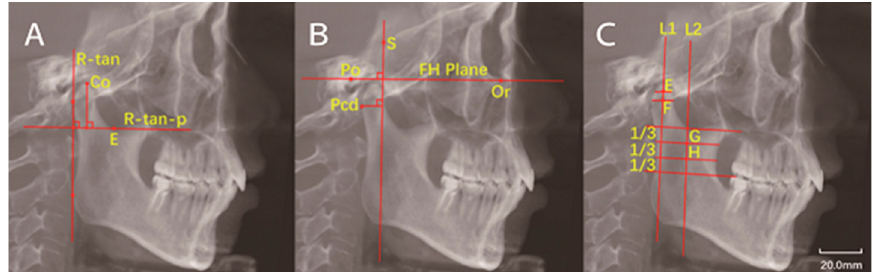
Figure 4. Measurements in the sagittal view of the condyle. ( A ): Condylar height—the distance from Co to the line perpendicular to the R-tan line and passing the deepest point of the sigmoid notch (R-tan- p ). ( B ): Pcd-FH- p (S)—the distance from Pcd to the line perpendicular to FH plane and passing S point. ( C ): Condylar neck angle—the center of the widest width of the condyle (F point) and the center of the middle part between the top and the widest width of the condyle were marked (E point); a line was drawn through these two points. The midpoints of the width of the superior border (G point) and the inferior border (H point) of the middle third of the ascending ramus were determined. Another line was drawn through these two midpoints. The angle between these two lines was defined as condylar neck angle. The angle was defined as positive if two lines intersected below the condyle and negative if they intersected above the condyle. (Co: Most superior point of the condyle; R-tan line: Tangent to the posterior border of the ramus; Pcd: Most posterior point of the condyle on sagittal plane; FH plane: Frankfort-horizontal plane; S point: Sella point; Po: The uppermost point of external auditory canal; Or: The lowest point of orbital margin.)